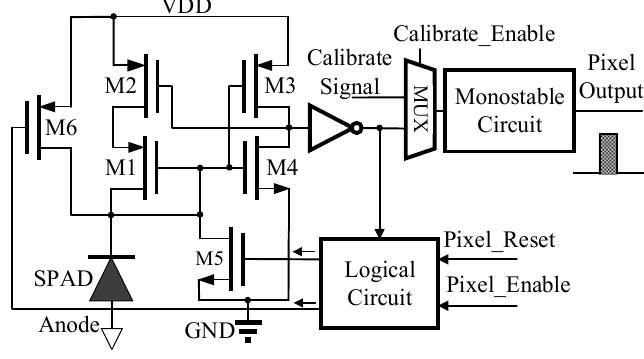
Figure 3. The in-pixel circuits.